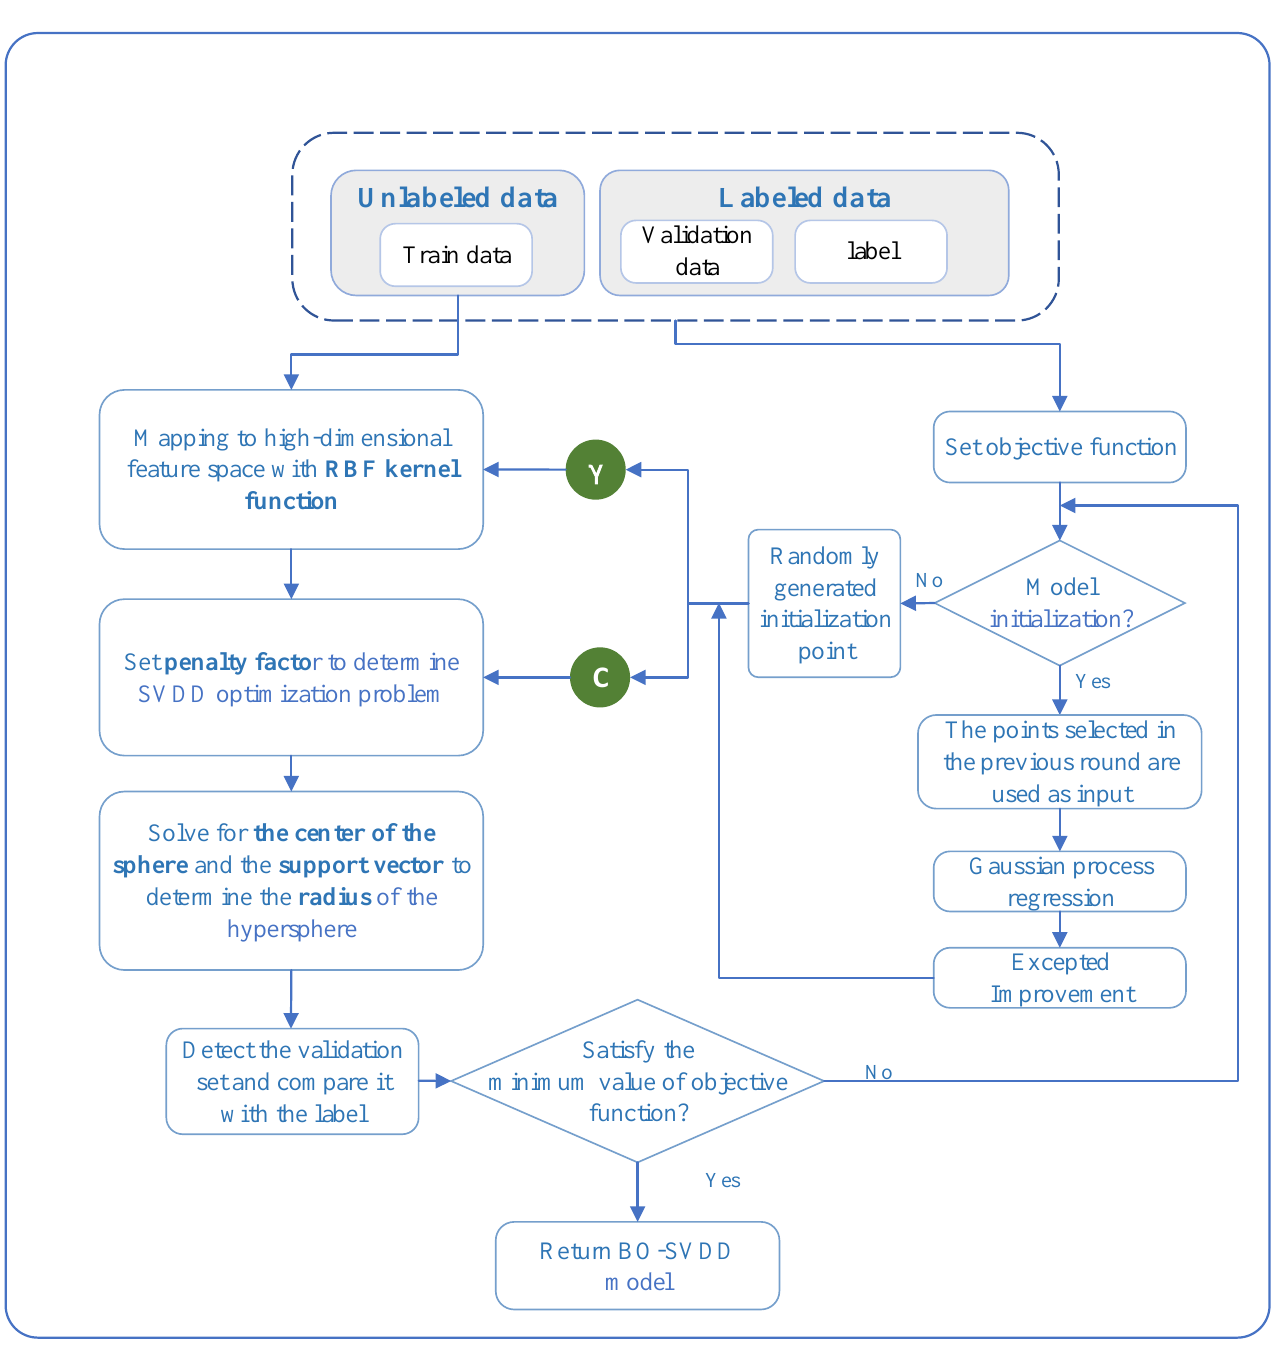
Figure 7. Fault detection model framework.